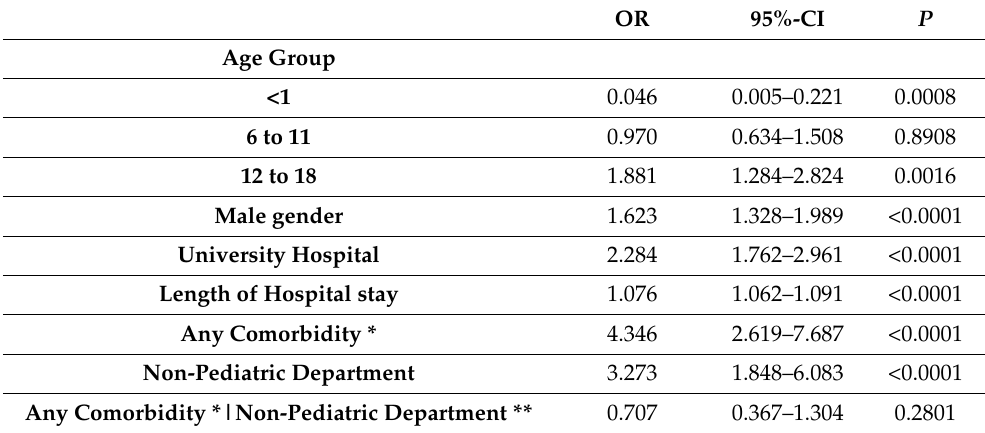
Table 9. Comparability of PD and non-PD with regard to the performance of CT. OR 95%-CI P Age Group <1